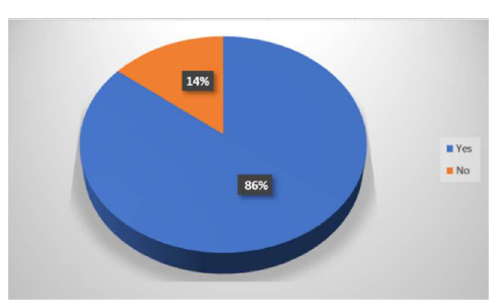
Figure 17. Answers to the fourth question of Unit A.